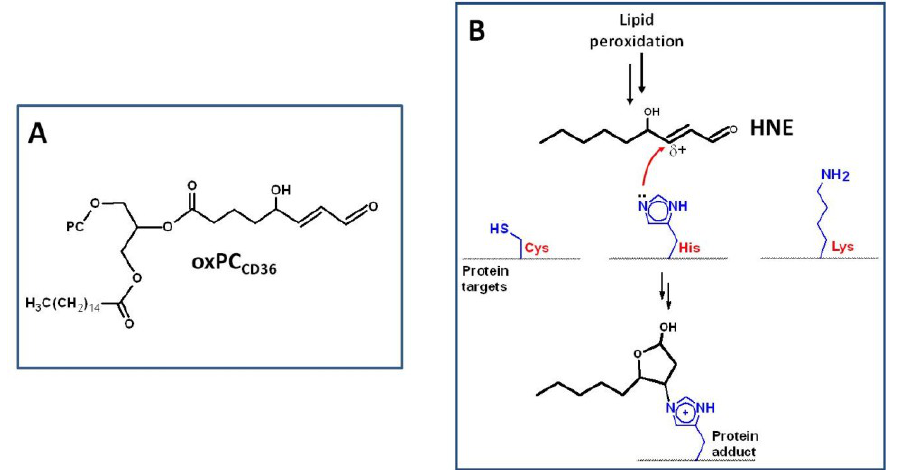
Figure 1. Structures of α,β-unsaturated electrophiles that can undergo Michael addition reactions with cellular nucleophiles. ( A ) Structure of oxPC phospholipid analogue of 4-hydroxynonenal (HNE); ( B ) Lipid peroxidation generates the diffusible aldehyde HNE, which can modify amino-acid side chains in proteins. Shown is the reaction between histidine and HNE, although HNE can also react with cysteine and lysine